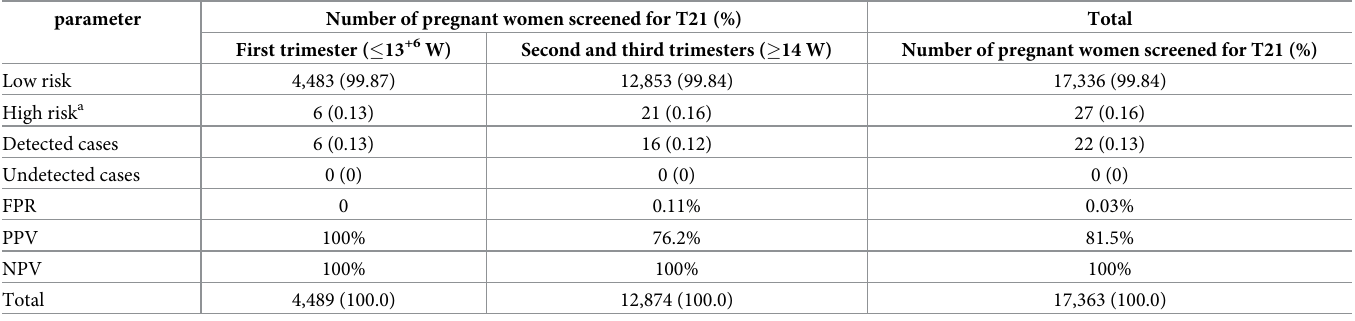
Table 2. List of Noninvasive prenatal testing